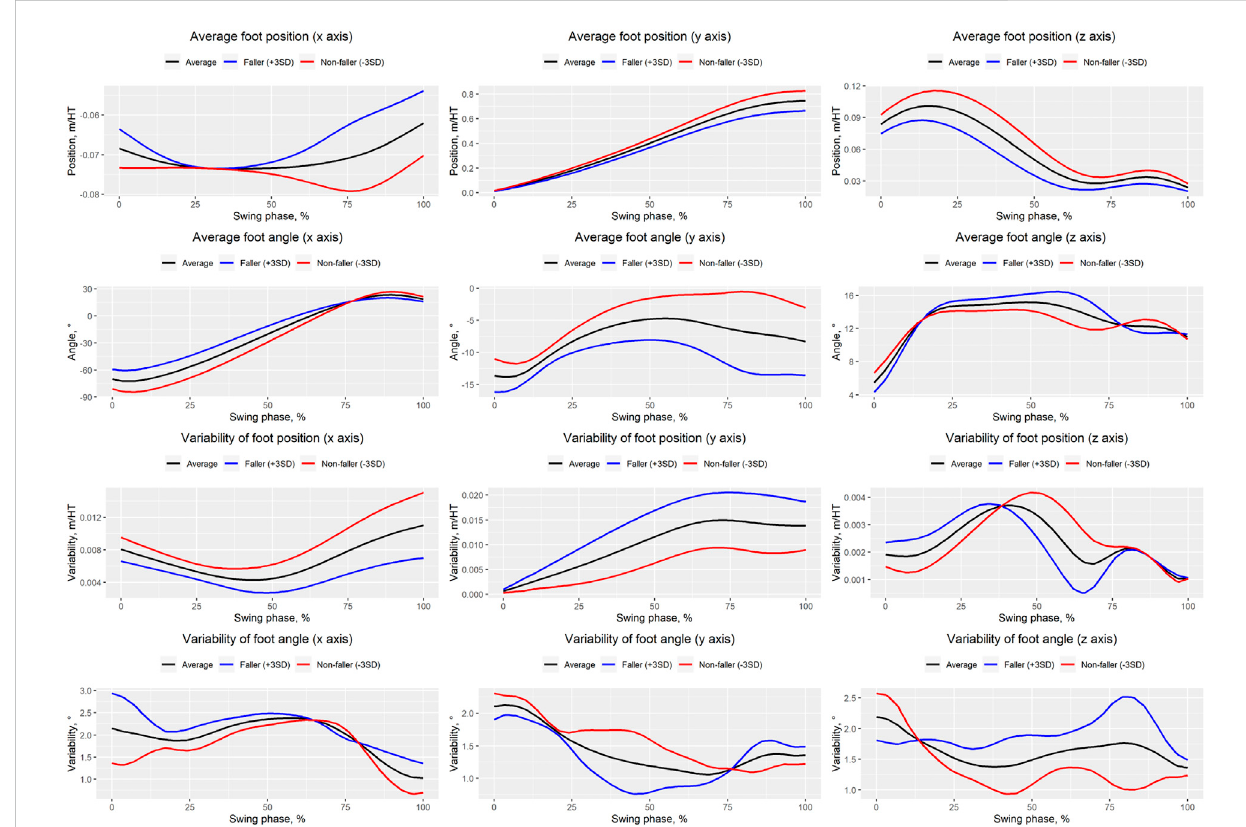
FIGURE 3 Waveforms of averages and variabilities of foot positions and angles during the swing phase. Black, blue, and red solid lines indicate the average, faller-like pattern ( + 3SD), and non-faller-like pattern ( − 3SD),